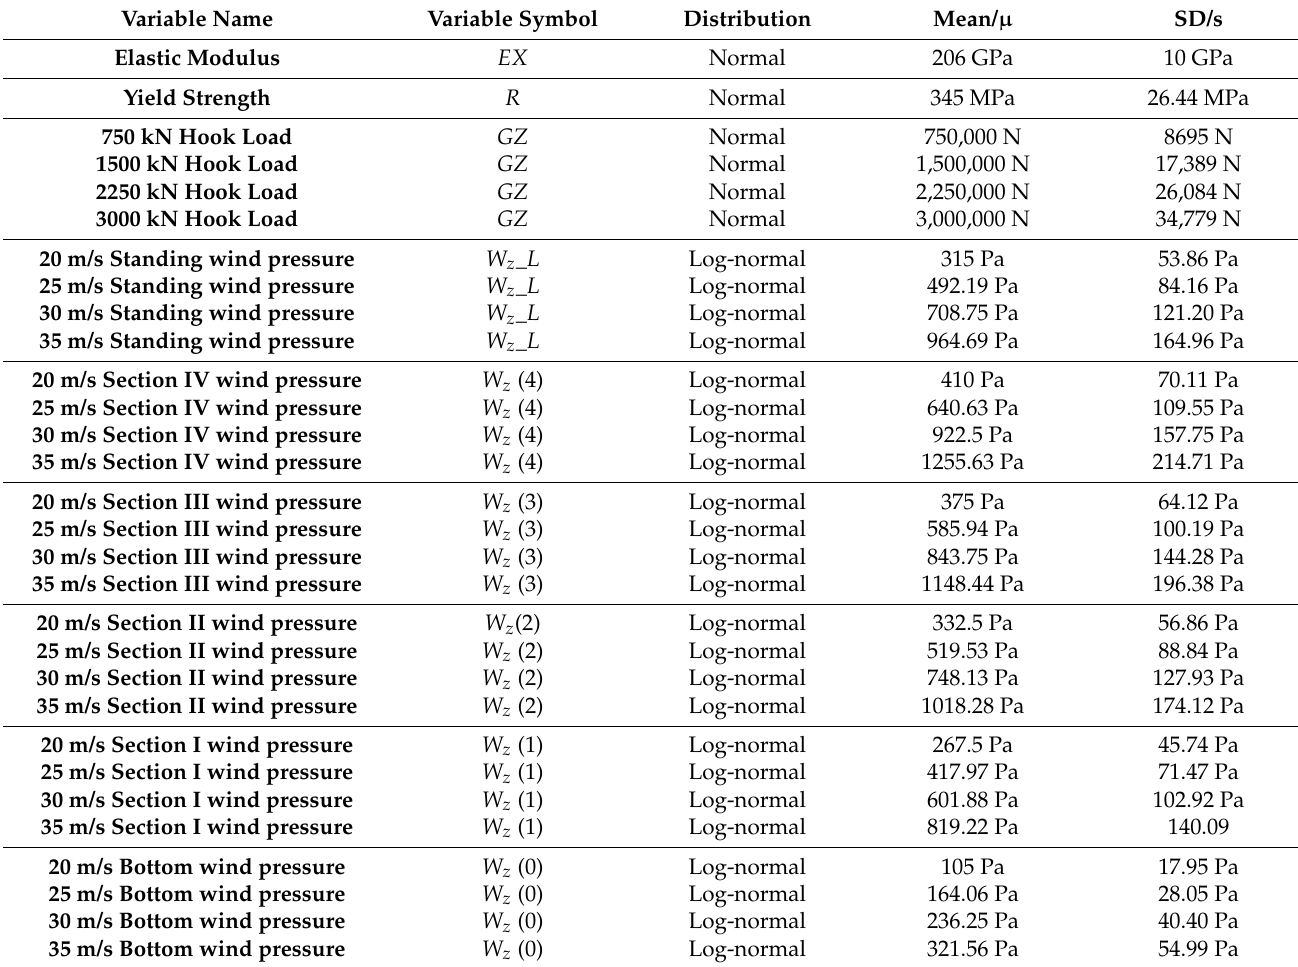
Table 3. Random variable distribution and numerical